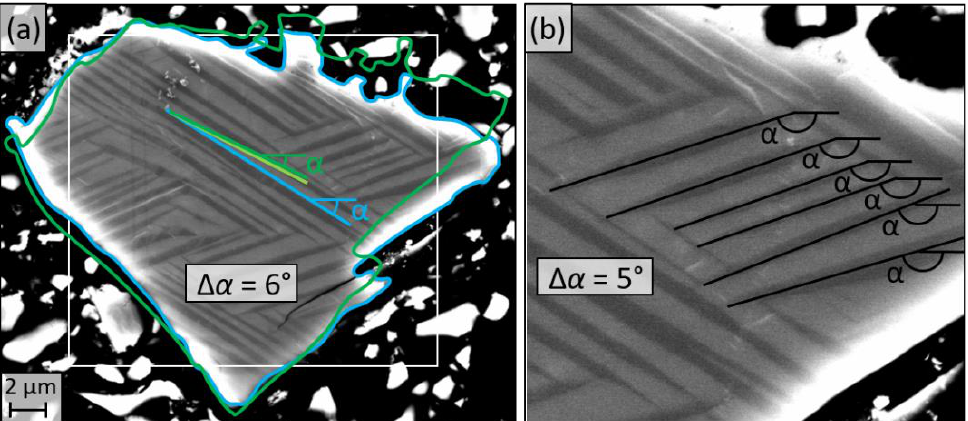
Figure A2. ( a ) Image distortions comparing the contours of the particle imaged in the untilted state (showing BSE contrast, contour line: blue) and the tilted state (contour line: green). ( b ) Spread of measured α angles in neighboring “parallel” bands with tapered ends if angle is measured close to the end.